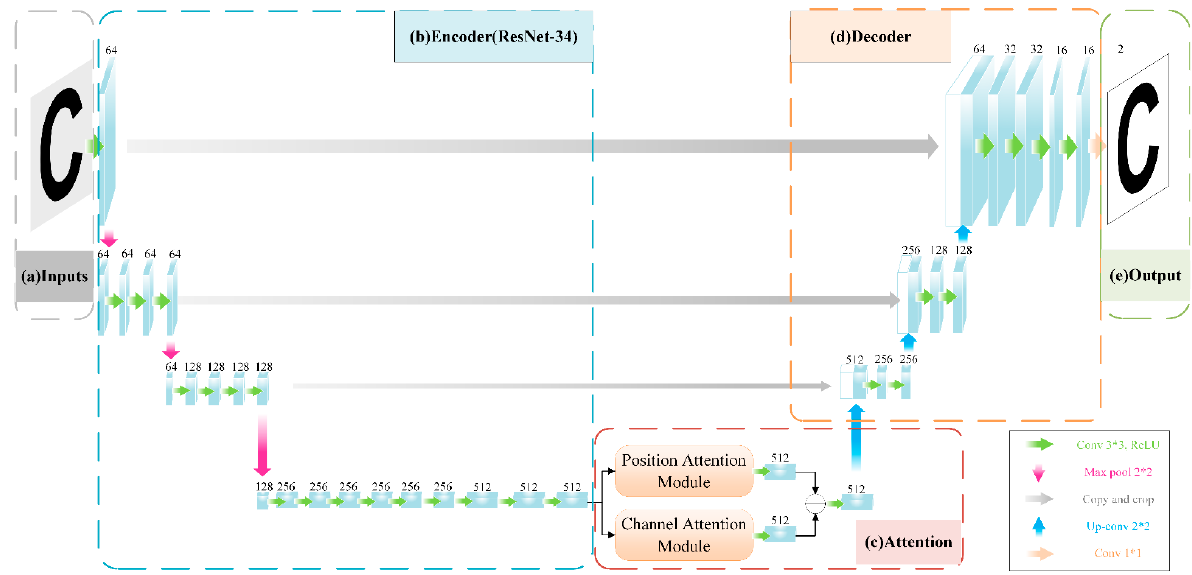
Figure 6. Overall structure of the proposed DAU-Net model. (Reprinted from Ref. [124]. 2021, Yibin Ren). ( a ) Inputs of DAU-Net: VV, VH, and incident angle. ( b ) Encoder of DAU-Net, based on ResNet-34. ( c ) Dual-attention structure we employed to optimize the original U-Net, including PAM, CAM, and three CNN blocks. ( d ) Decoder of DAU-Net. ( e ) Output module of DAU-Net. On the other hand, with the continuous development of DL in the field of computer vision, scholars in the field of SAR water-body segmentation are also trying more ad- vanced network models, such as DeepLab and High-Resolution Network (HRNet) to seg- ment water bodies in SAR images. In 2021, Kim, M. et al. [125] employed representative DL segmentation models, such as FCN, U-Net, DeepUNet, and HRNet, to perform water- body segmentation tasks in KOMPSAT-5 images. DeepUNet is a deeper model with more layers than U-Net. The characteristic of the model is to add a ’plus layer’, which can pre- vent loss of network from expanding and the model from falling into local optimization.